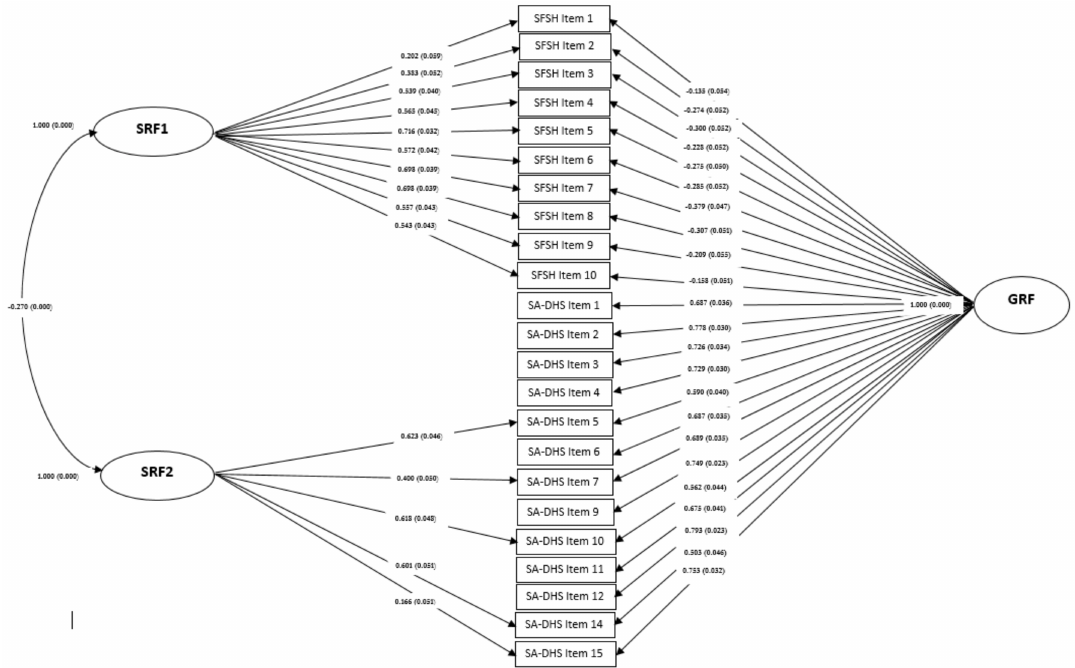
Figure 1. Path diagram of the bifactor solution GRF = General Reference Factor, Contentment; SRF1 = Specific Residual Factor, Fluctuating factor; SRF2 = Specific Residual Factor,